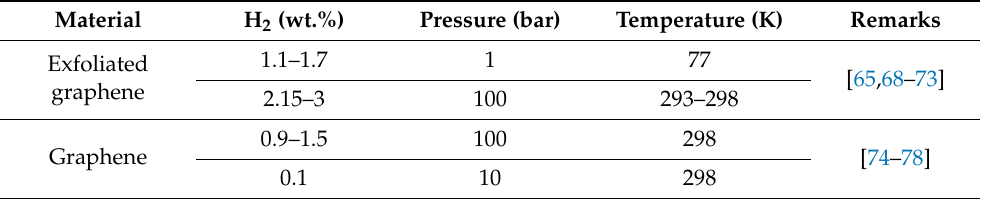
Table 1. Basic parameters of hydrogen storage with the use of